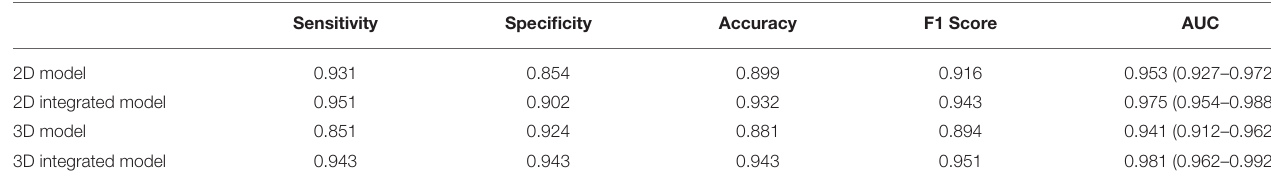
TABLE 3 | Performance comparison for two-class classification of brain atrophy in test set, in terms of sensitivity, specificity, accuracy, F1 score, and area under the curve (AUC).